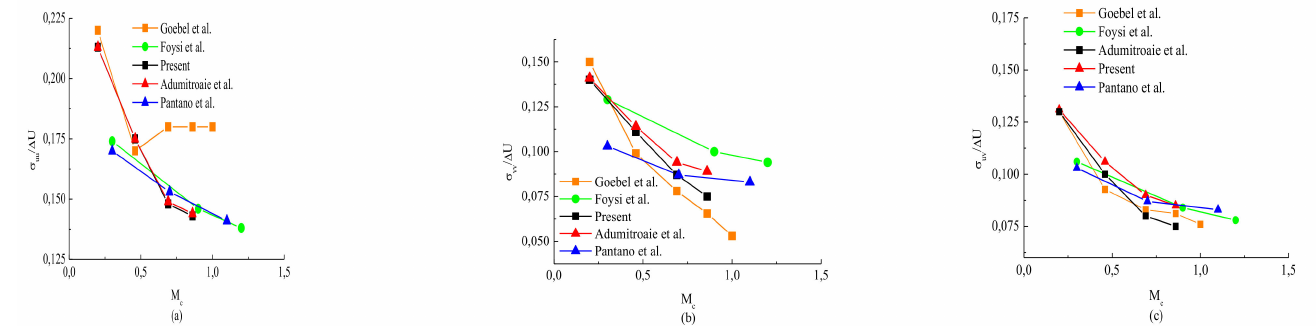
Figure 14. The influence of the convective Mach number on the maximum Reynolds stress: